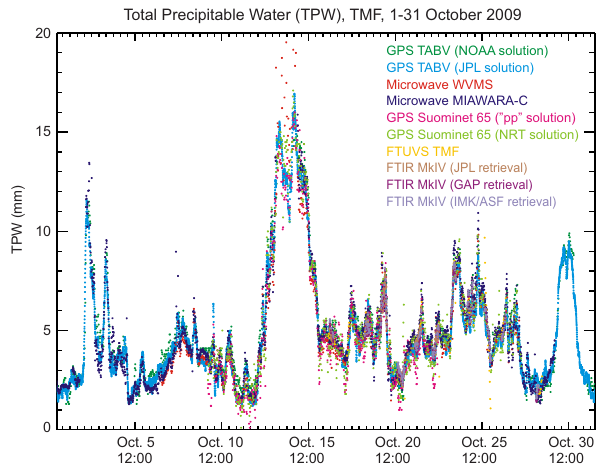
Fig. 14. Time series (1–31 October 2009) of the Total Precip- itable Water datasets obtained from the two GPS, two microwave radiometers, and two Fourier Transform Spectrometers deployed at TMF during MOHAVE-2009. Sampling interval varies between 10- min and